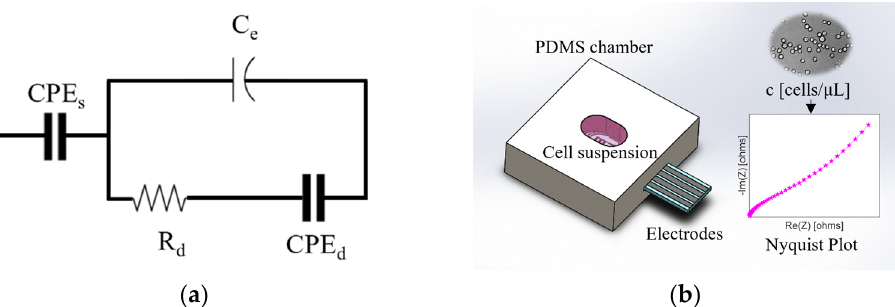
Figure 2. ( a ) Equivalent electrical circuit to model the electrical impedance data of particle suspensions or biological cell suspensions; ( b ) electrodes embedded in a PDMS chamber for EIS measurements.